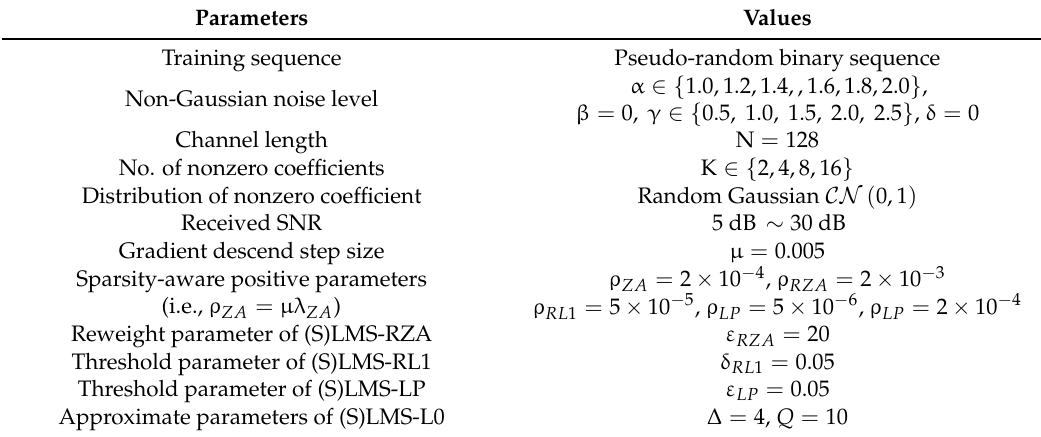
Table 1. List of computer simulation parameters in robust adaptive sparse channel